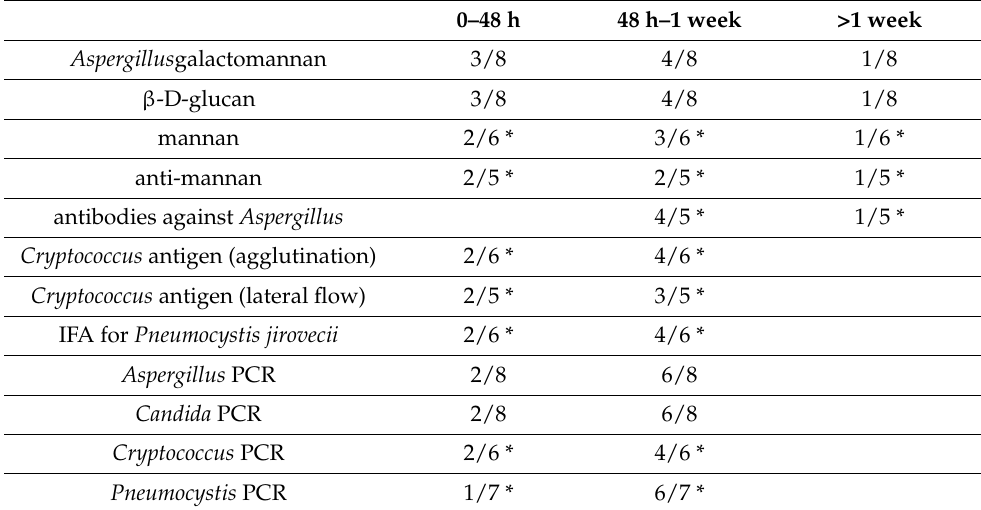
Table 5. Non-culture-based methods’ turnaround time depending on the unit.